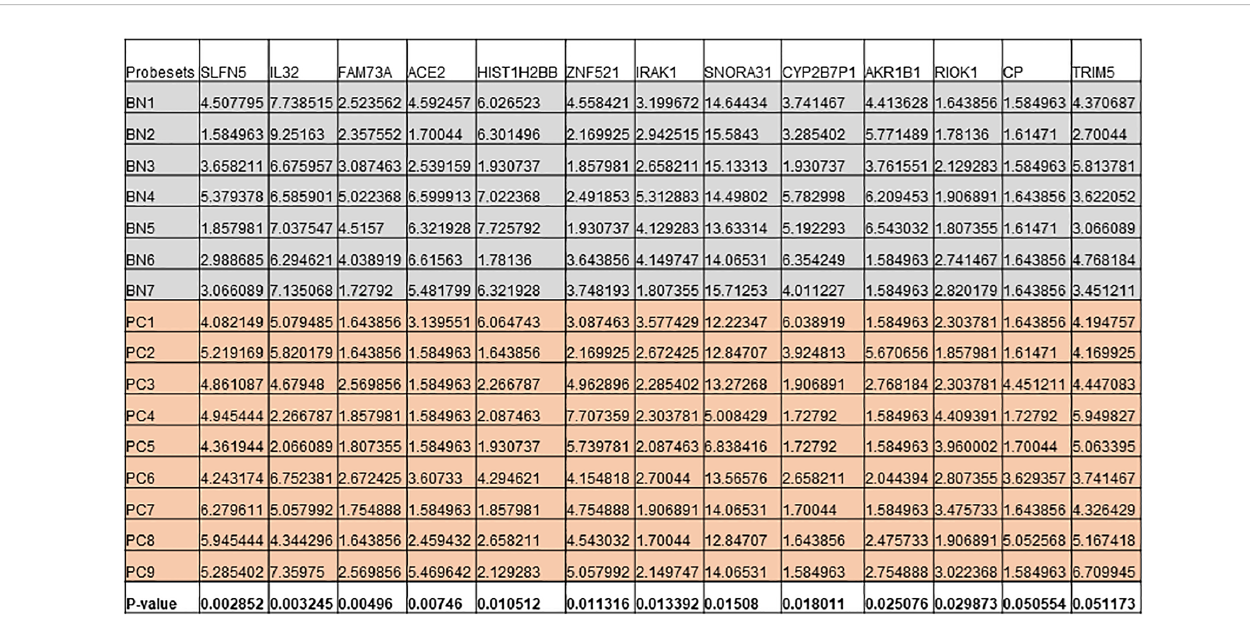
FIGURE 6 Expression levels of genes that are differentially expressed in both cell lines and patient cohort in Benign (BN) and Pca